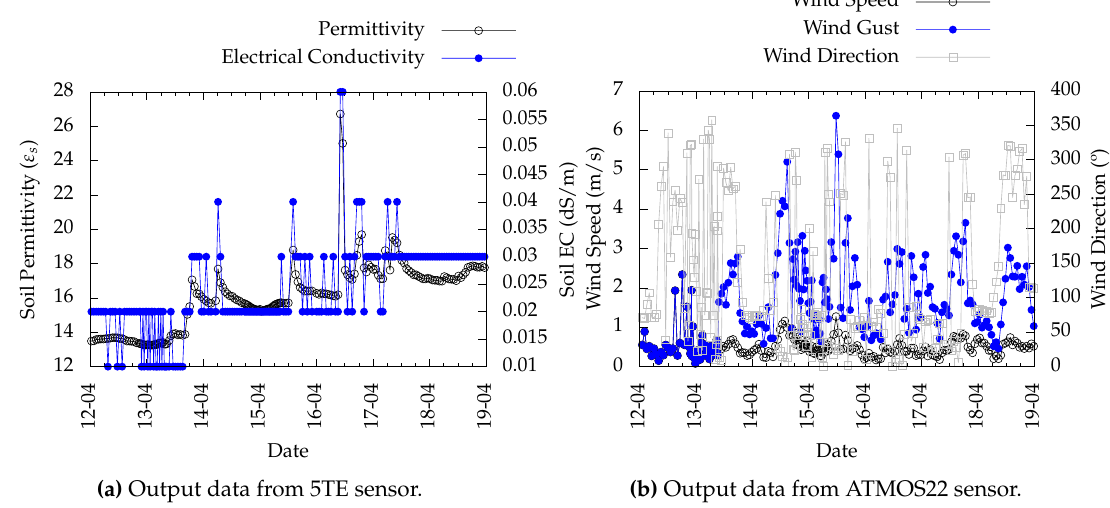
(b) Output data from ATMOS22 sensor. Figure 10. Data from LoRaWAN node with 5TE and ATMOS22 sensors. Figure 10. Data from LoRaWAN node with 5TE and ATMOS22 sensors. Figure 10. Data from LoRaWAN node with 5TE and ATMOS22 sensors.